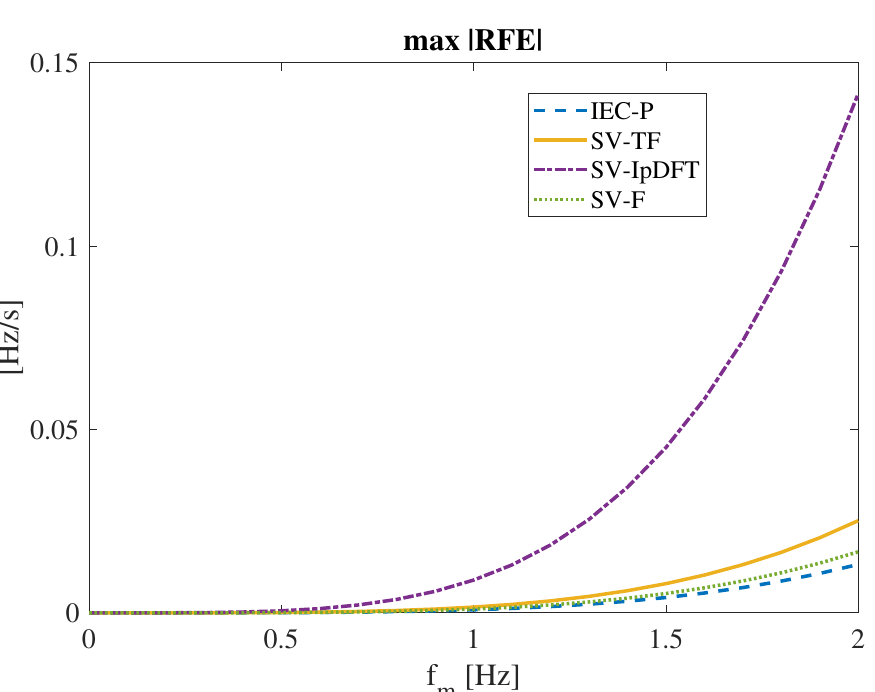
Figure 19. Maximum |RFE| results under phase-angle modulations with modulation frequency f m